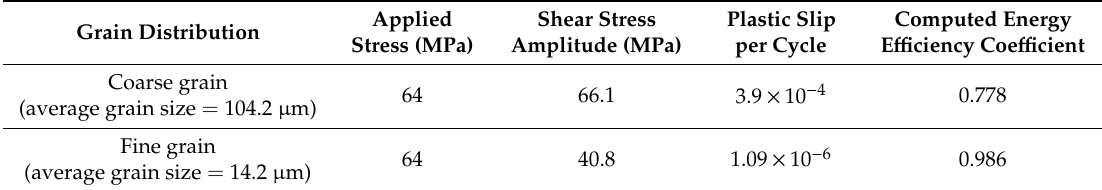
Table 4. Cyclic loading-computed parameters.